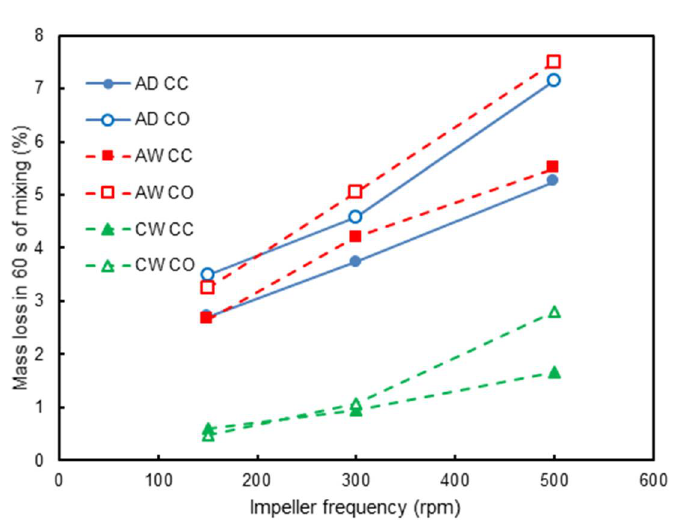
Figure 10. Experimental results on the effect of impeller frequency on the mass loss for tests with coarse aggregates only (AD, dry mixing, and AW, wet mixing) as well as a concrete formulation (CW), co- and counter-current configurations and 60 s of mixing.